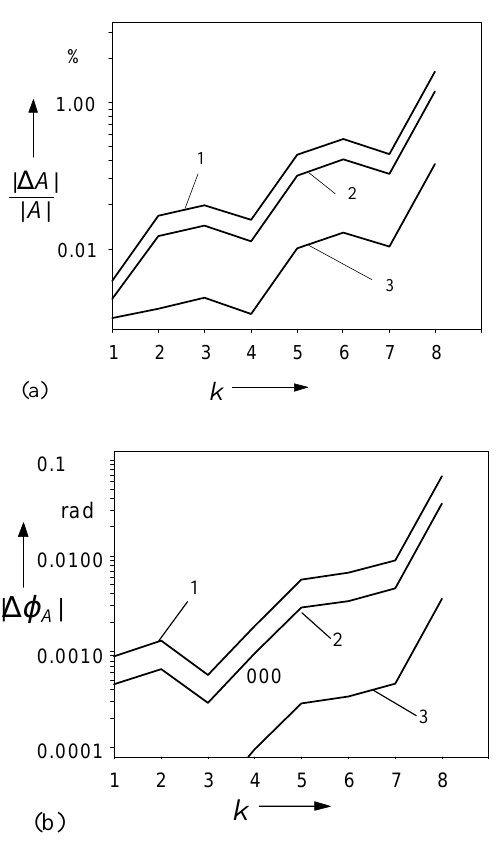
Fig. 9. (a) Relative amplitude error | ∆ A | / | A | and (b) phase error | ∆ ϕ A | of the acceleration spectrum obtained for non-ideally gener- ated quadrature signalswith | ρ | = 0 . 2 , 0.1 and 0.01 rad (trace 1, 2 and 3). Impulse parameters: a G,m = 10 4 m/s 2 , T G = 50 µ s.